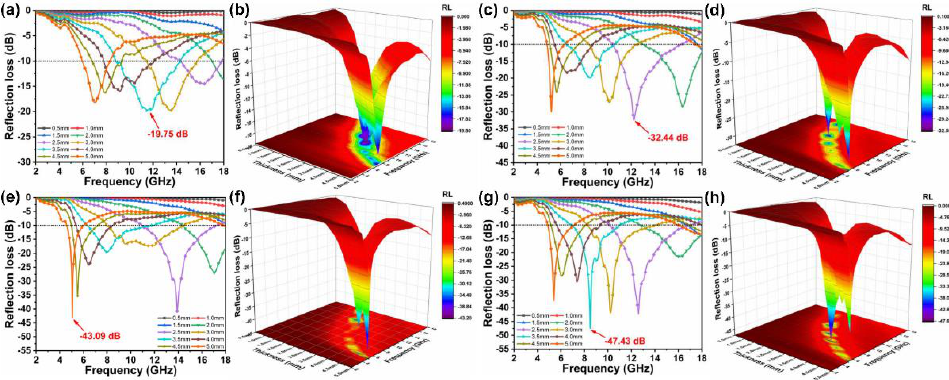
Figure 4. The RL of the composite foams with different thicknesses at different frequencies: ( a , b ) PU/CNT/Fe 3 O 4 , ( c , d ) PU/WTR@CNT/Fe 3 O 4 — 1:1, ( e , f ) PU/WTR@CNT/Fe 3 O 4 — 1:1.5, and ( g , h ) PU/WTR@CNT/Fe 3 O 4 — 1:2.